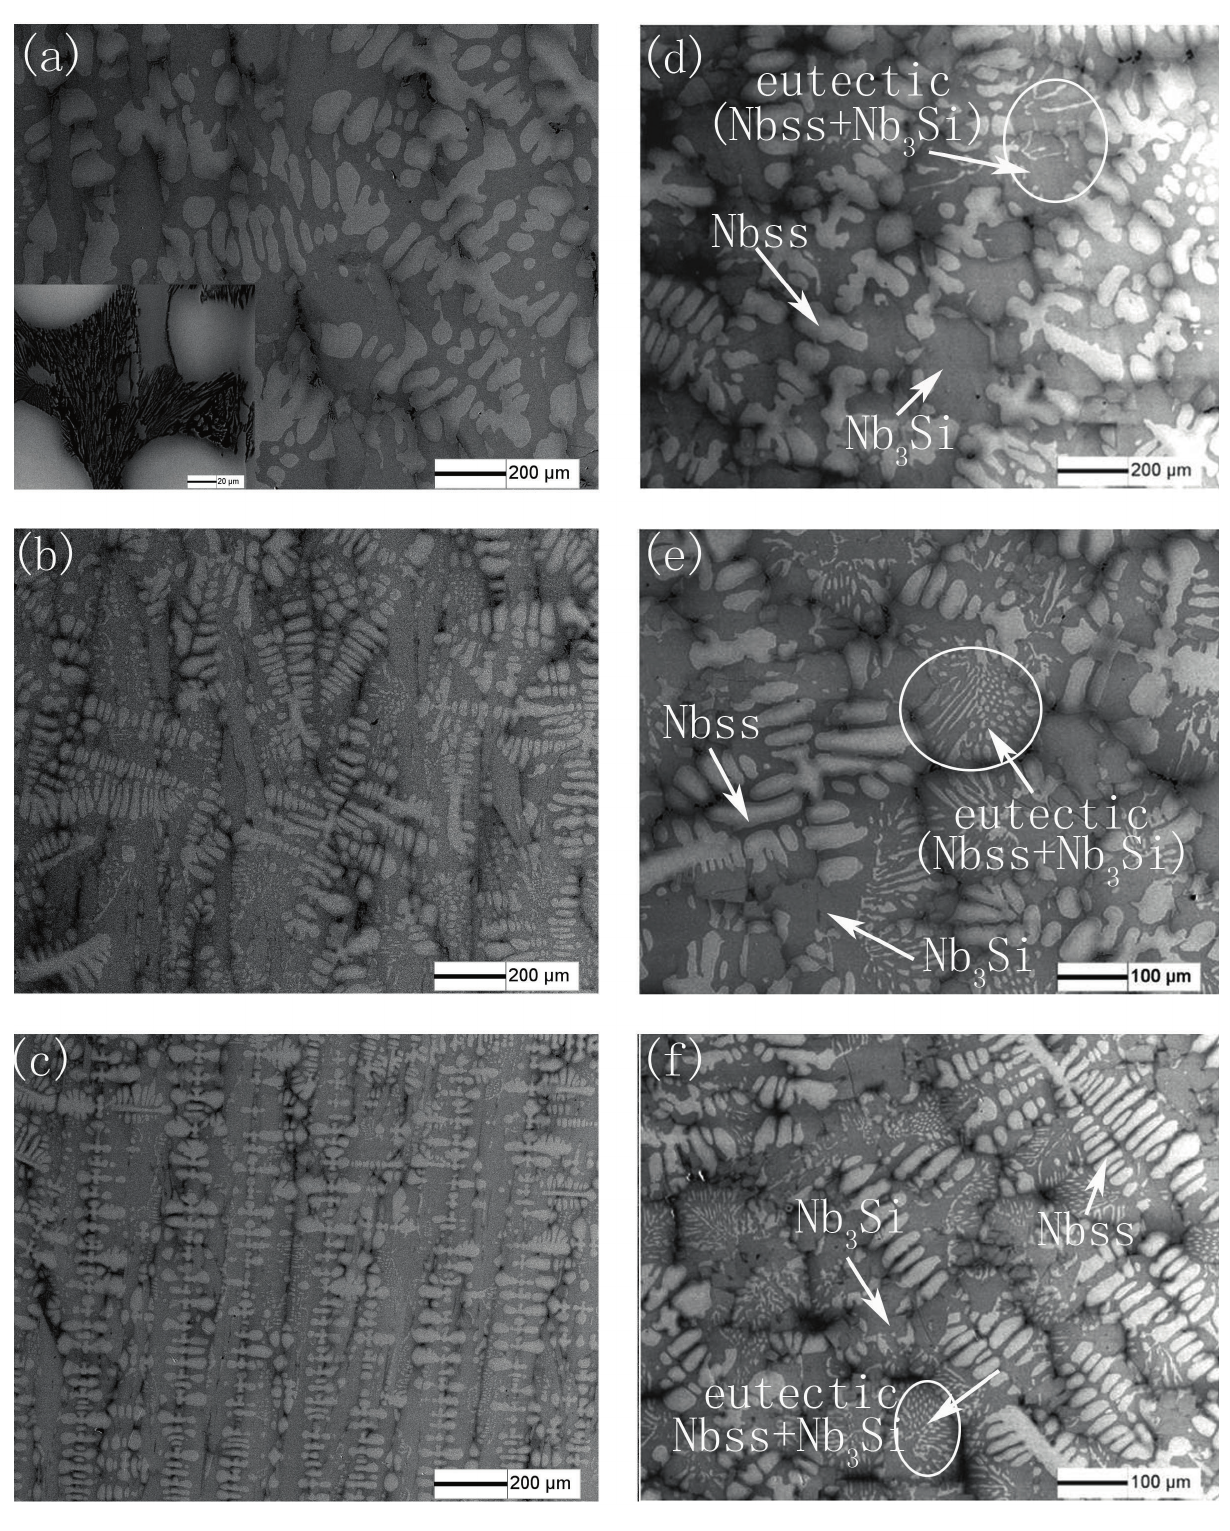
Figure 1. Longitudinal (a, b, c) and transverse (d, e, f) microstructures of a directionally solidified alloy for different withdrawal rates at a constant temperature rate of 1900 ı C: (a, d) 1.2 mm = min; (b, e) 6 mm = min; (c, f) 18 mm =